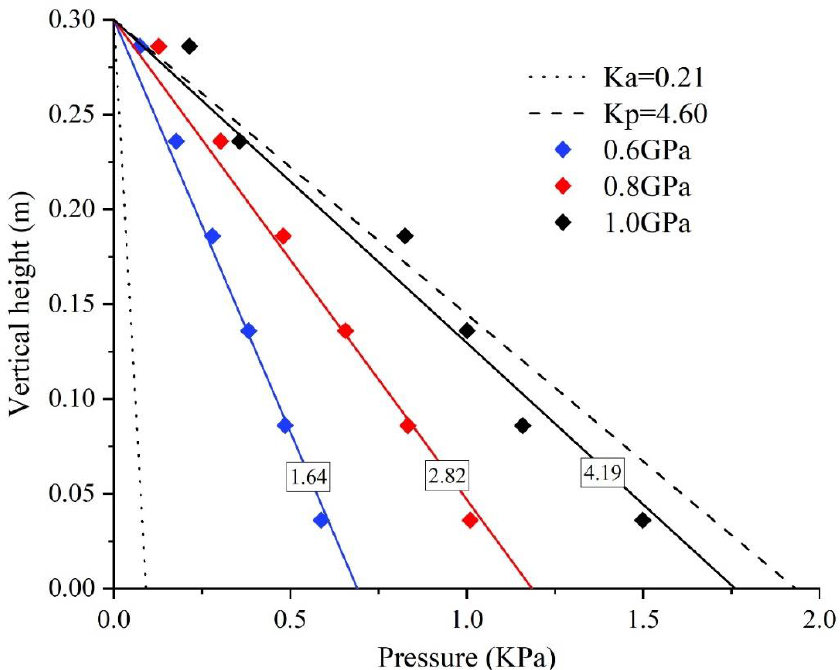
Figure 5. Static earth pressure distribution of deposited sand.